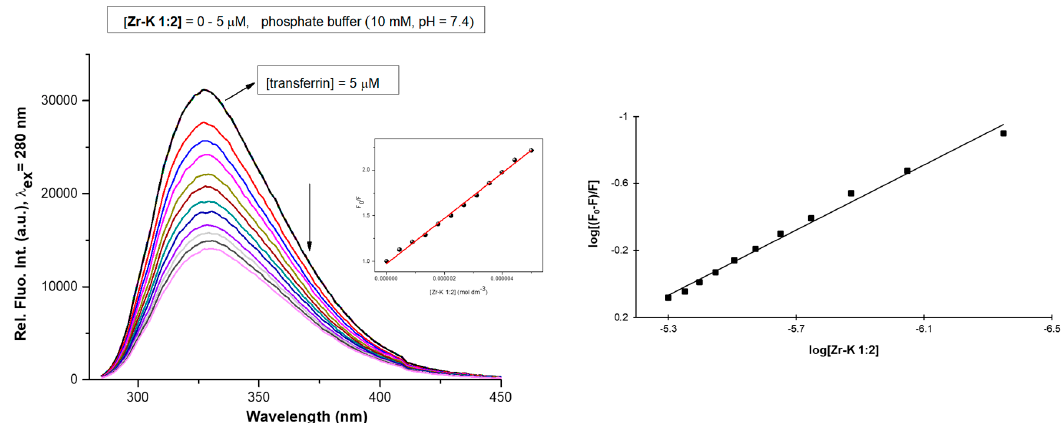
Figure 4. Tryptophan fluorescence quenching spectra of transferrin (5 µM) in phosphate buffer (10 mM, pH 7.4) with increasing concentrations of Zr-K 1:2 (0–5 µM). The insert shows a plot of F 0 /F versus the POM concentration. (Right) Derived Stern-Volmer plot used to calculate the association constant.